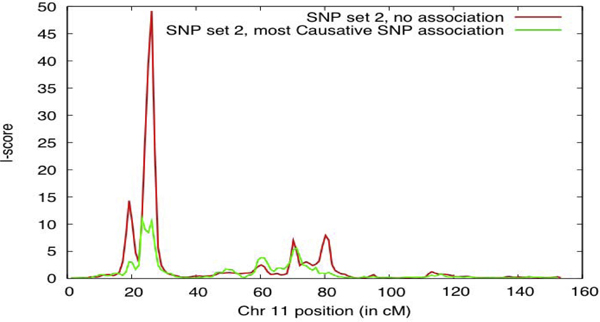
Associated SNPs account for linkage peaks. L-scores for MCMC oligogenic linkage analysis of LDL with (green) and without (red) simultaneous association testing at most causative SNPs. Including the causative SNPs reduces the linkage signal in most regions.